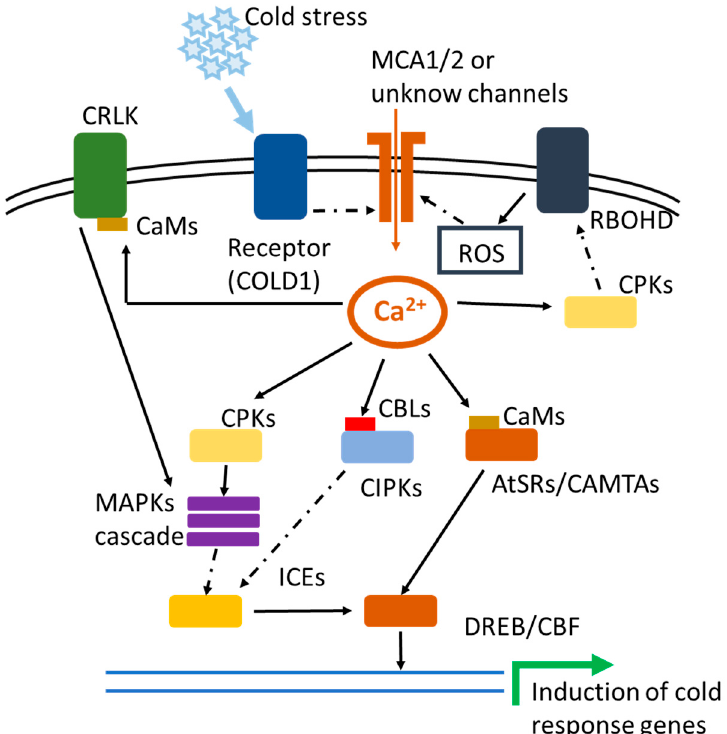
Figure 1. Calcium signaling-mediated plant response to cold stress in Arabidopsis . The perception of cold stimulus is the first step in the activation of cold tolerance in plants. Plants sense cold signals through the recognition of the changes in cellular membrane by cold stress, or cold signals sensor, COLD1. The perception of cold stimulus activates cold responsive Ca 2+ channels (MCA1 and MCA2) or other unknown Ca 2+ channels and/or pumps to induce Ca 2+ transients, also knowns as Ca 2+ signals or signatures. The cold stress-induced Ca 2+ transient changes in plant cell and the expression of AtSRC2 subsequently facilitate the production of ROS, through the activation of Ca 2+ -mediated NADPH oxidase activity of AtRBOHF. Enhanced ROS further activates Ca 2+ channels and/or pumps for inducing Ca 2+ transients to form a positive feedback. CPKs also relay cold-triggered Ca 2+ signals into phosphorylation and activation of the MAPK cascade. In addition, the MAPK cascade is activated by CRLK1 or CRLK2 through the interaction with calmodulin (CaM) in response to cold stress. The MAPK signaling pathway triggered by cold stress suppresses the degradation of ICE1 to establish cold tolerance in plants. CaM also relays cold stress-triggered changes into transcriptional reprogramming via AtSR1/CAMTA3. Solid arrows represent physical interaction and/or positive regulation (induction). Dashed arrows represent mechanism that is unclear.